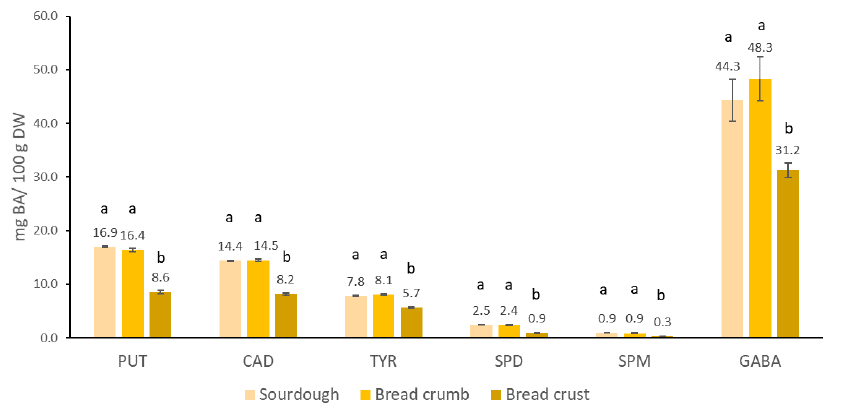
Figure 6. The content of biogenic amines (PUT—putrescine; CAD—cadaverine; TYR—tyramine; SPD—spermidine; SPM—spermine) and GABA in bread prepared from Flour-2 chickpea sourdough. Values marked with a different letter (a, b) differ significantly in BAs and GABA in sourdough, bread crumb and crust prepared from Flour-2 chickpea. The differences were significant at the p < 0.05 level.